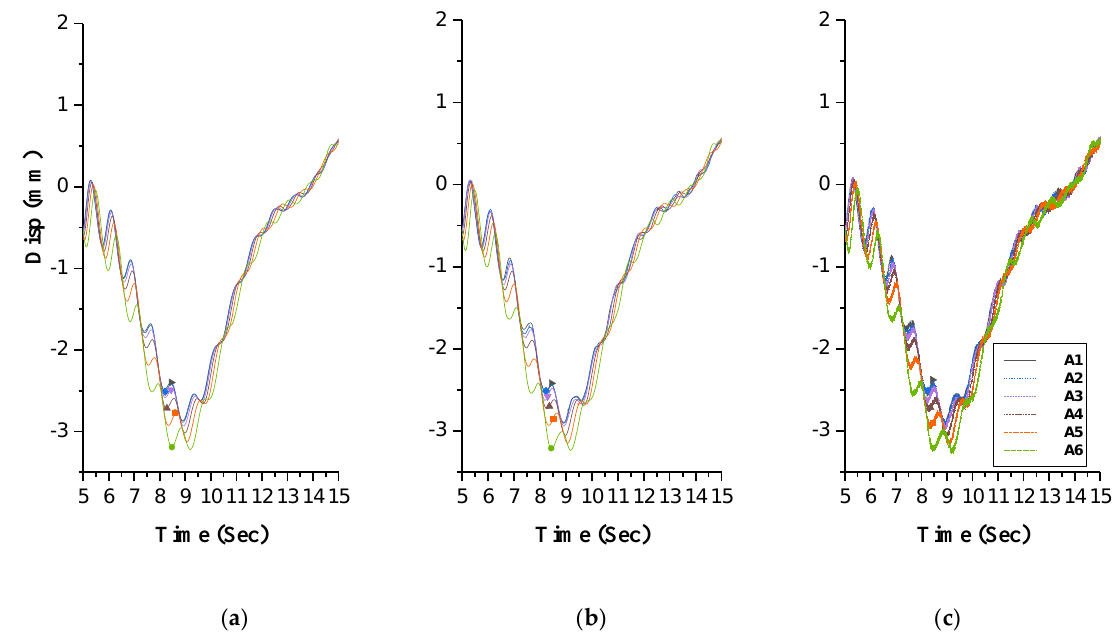
Figure 18. The test bridge displacement time histories of the 1/2 midspan under various damage/activities: ( a ) theoretical calculation results by Midas; ( b ) measured values based on the proposed method; ( c ) measured values based on displacement